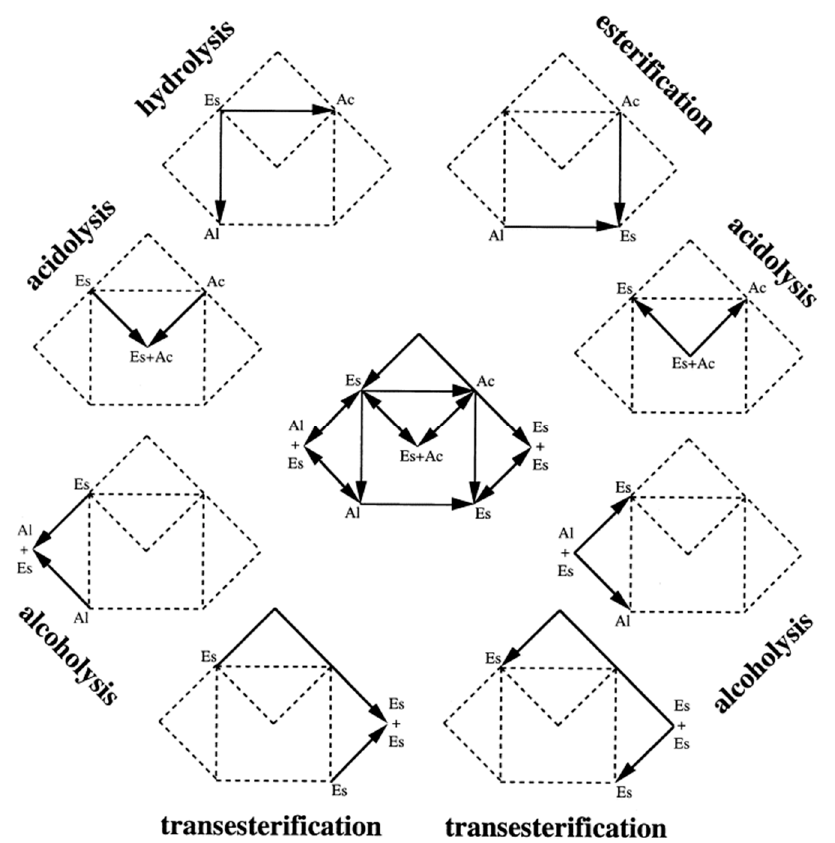
Figure 1. Wireframe of the lipase-catalysed reaction domain. Es, Al and Ac are the shortenings of esters, alcohols and acids respectively. Reactants are depicted before the beginning of arrows, products are depicted after the end of arrows, reproduced with permission from [19]. Copyright 2000,